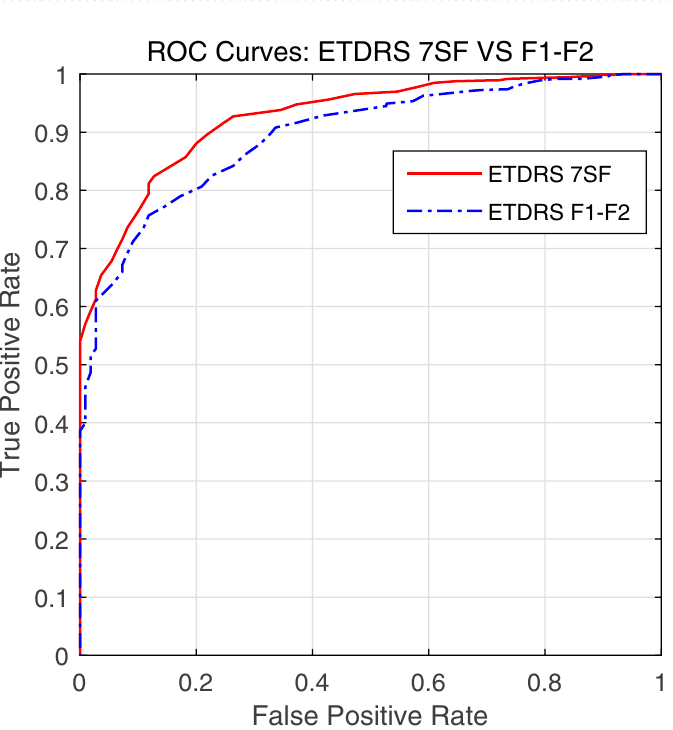
ROC Curves: ETDRS 7SF VS F1-F2